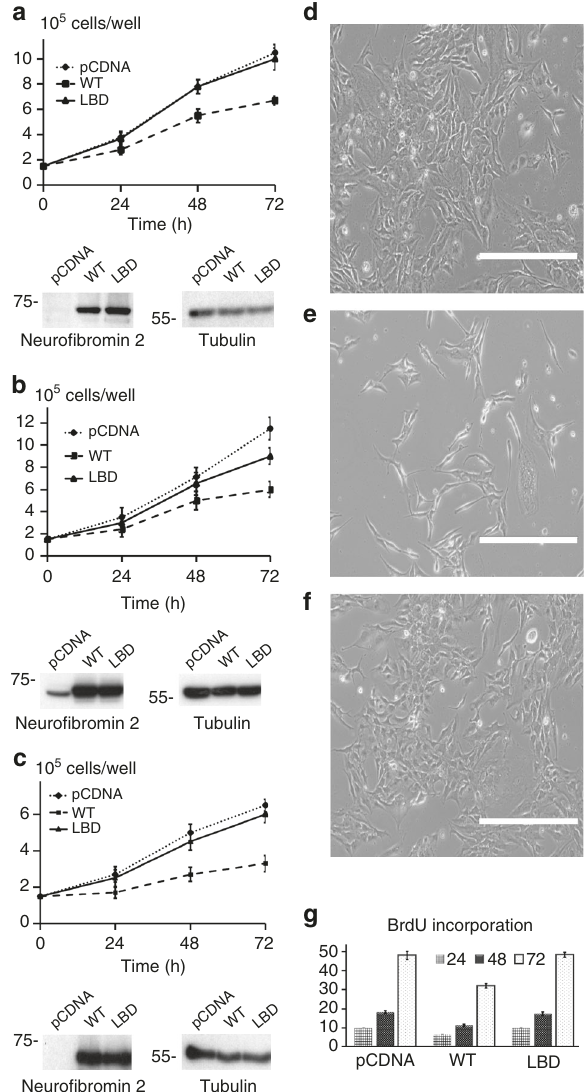
m. d – f Phase contrast microscopy images, taken at the 72 h time point, of SC4 cells that were used in the BrdU cell proliferation assay. SC4 cells lipid binding de fi cient mutant. g Cells expressing lipid binding de fi cient mutants of neuro fi bromin 2 display impaired inhibition of BrdU incorporation. SC4 cells were transfected with expression vectors for wild type and lipid binding de fi cient neuro fi bromin 2 or empty vector control (pCDNA) and BrdU incorporation was assessed over 72 h. Means of each data point were calculated from three independent biological replicates conducted in triplicate. Error bars represent ± S.D. Difference between pCDNA and our lipid binding de fi cient mutant neuro fi bromin 2, <1.0000 (i.e., not signi fi cant); pCDNA and wild-type neuro fi bromin 2, <0.000 (i.e., signi fi cant); wild type and our lipid binding de fi cient mutant, <0.0001